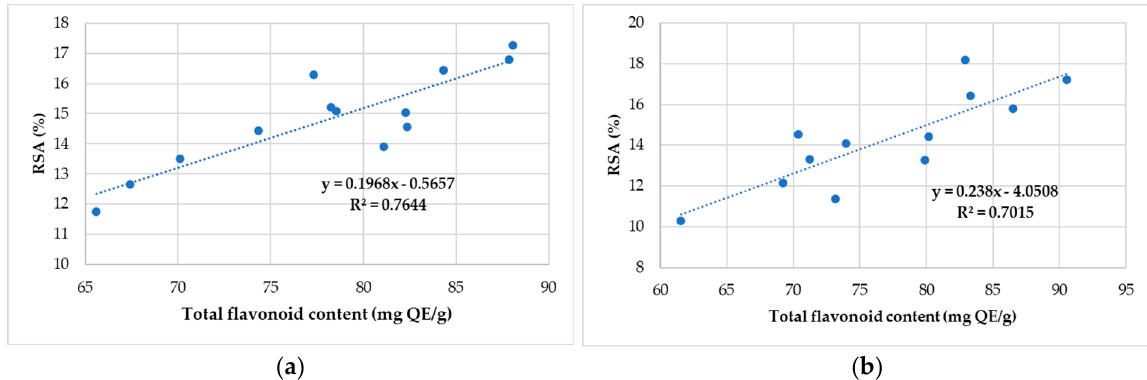
Figure 3. Correlation between antioxidant activity and total flavonoid content of the propolis sample collected ( a ) from North-West and Central Romania and ( b ) from Alba County. (SS5—S ona), and for flavonoid content between 61.56 (SS10—Cugir) and 90.54 ,